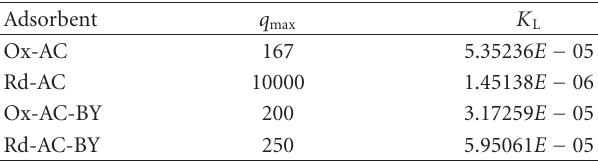
Table 4: The calculated Langmuir’s